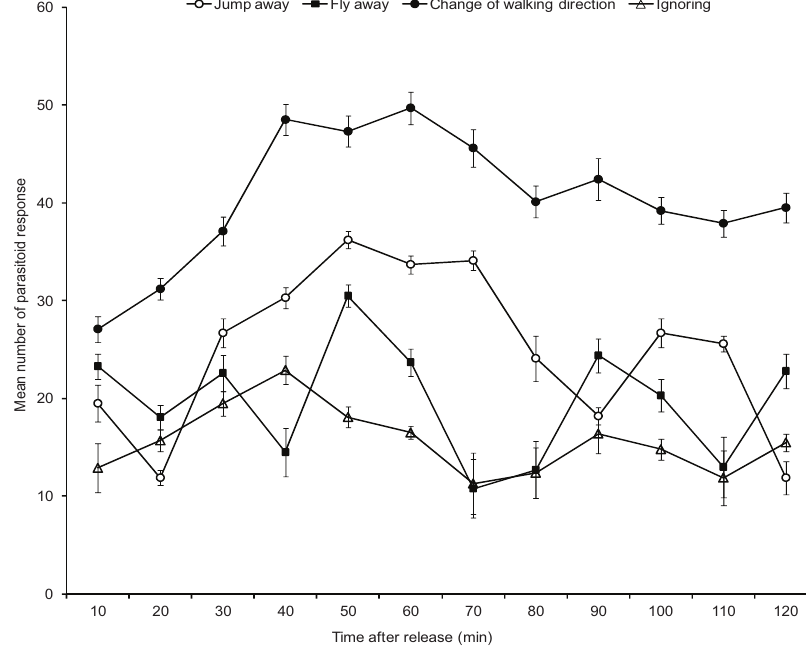
Figure 6. The mean (±standard error) number of behavioural responses displayed by the parasitoid Anagyrus pseudococci to evade encounters and attacks by Oecophylla longinoda at 10 min intervals over a 2 h observation period.